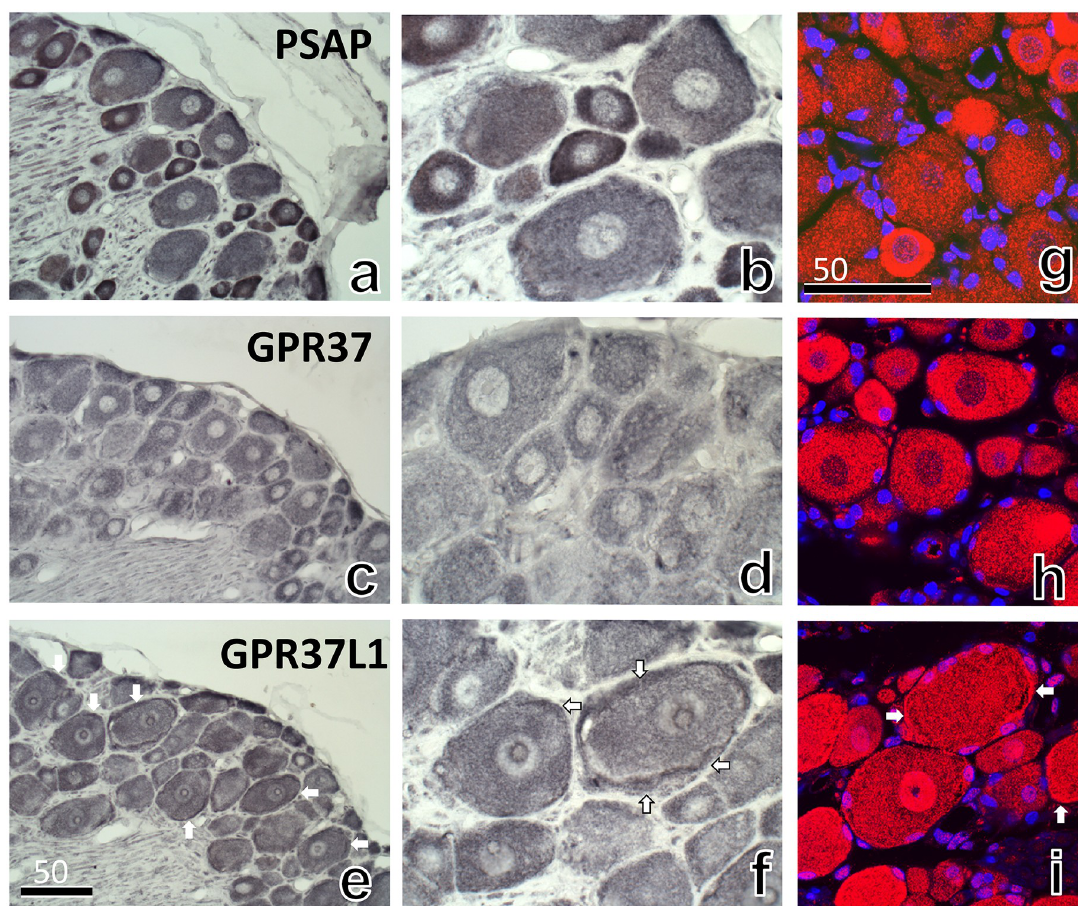
Fig 3. DAB immunohistochemical analyses (a–f) and immunofluorescence (g–i) with antibodies against PSAP (IM-1) (a, b, g), GPR37 (c, d, h), and GPR37L1(e, f, i) in the DRG of rats at 8 weeks after birth. (b, d, and f) Higher magnification images of a, c, and e, respectively. Intense granular PSAP reactions were observed in small neurons, and large dot-like structures were observed in large neurons (b). Similar reactions were shown by immunofluorescence (g). GPR37 exhibited dot-like reactions that were not as strong as those observed with PSAP. GPR37L1 reactivity was similar to that of GPR37 in neurons, and was strong in satellite cells (arrows in e, f, and i), especially those around larger neurons. The numbers on the bars indicate the scale in μ